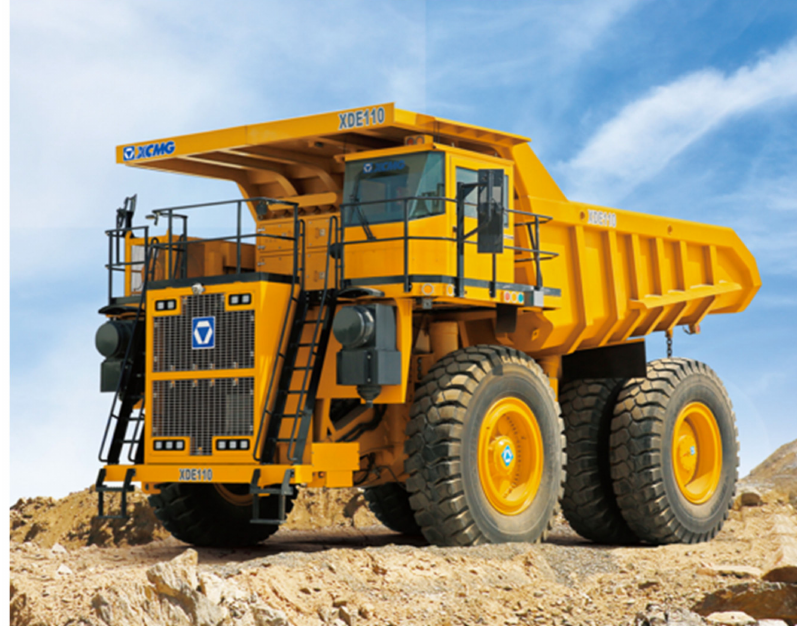
Figure 1. A mining truck of XCMG [14].